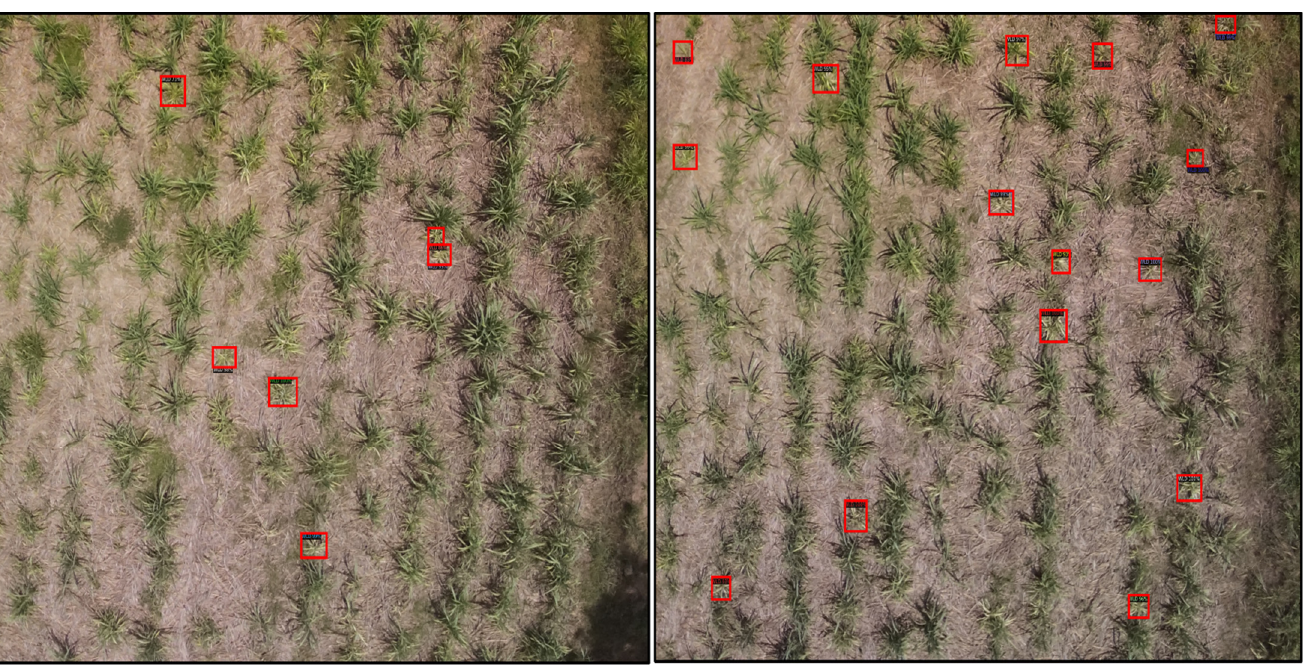
Figure 18. Bounding box detection using faster R-CNN.